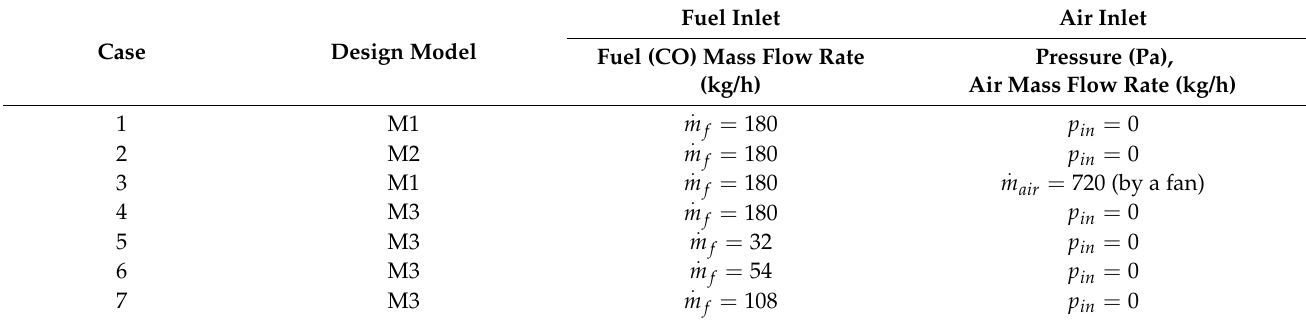
Table 4. The boundary conditions.